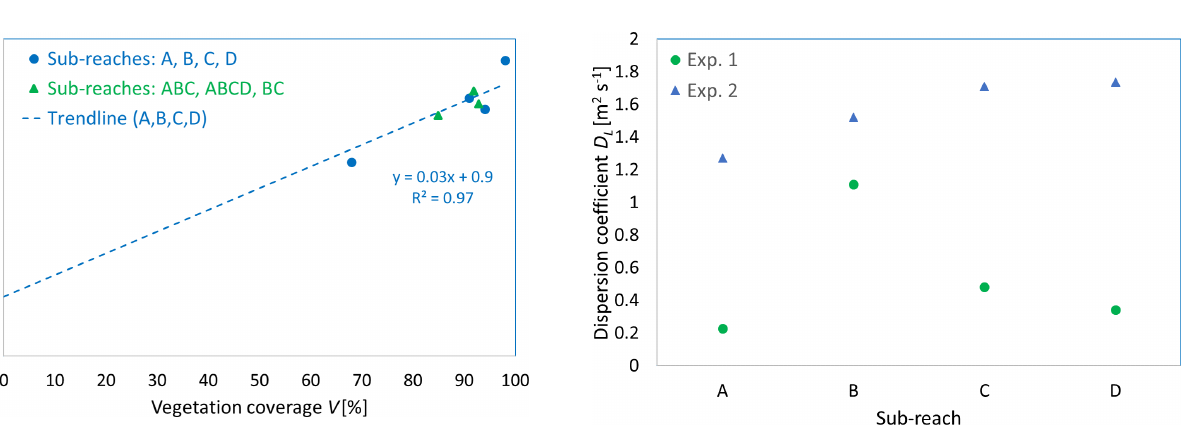
Figure 10. Ratio of sub-reach mean velocities between non- vegetated ( U NV ) and vegetated conditions ( U VEG ) as a function of the vegetation coverage ( V ).